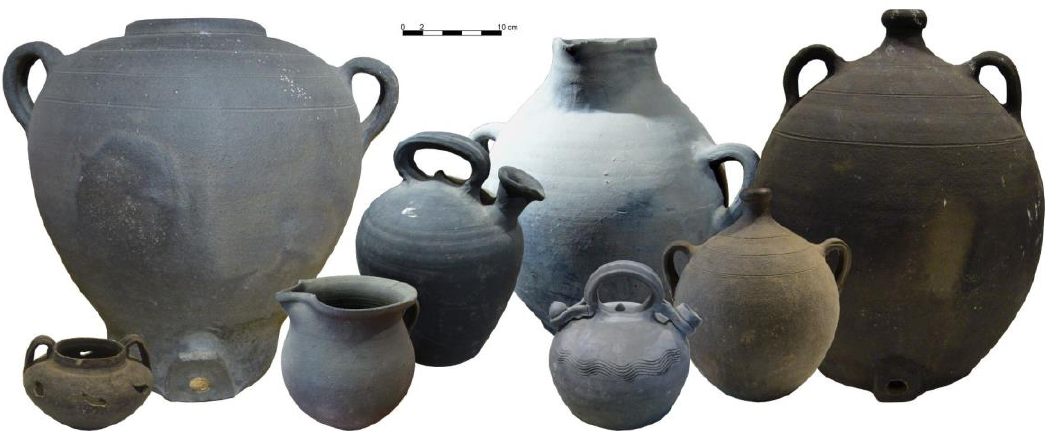
Figure 1. Selection of vessels representative of later periods of greyware pottery in Catalonia. These are pitchers, jars or jugs together with a wine measure, a heating pot and a brazier. All of them were part of the permanent collection at the former Pottery Museum of Quart.